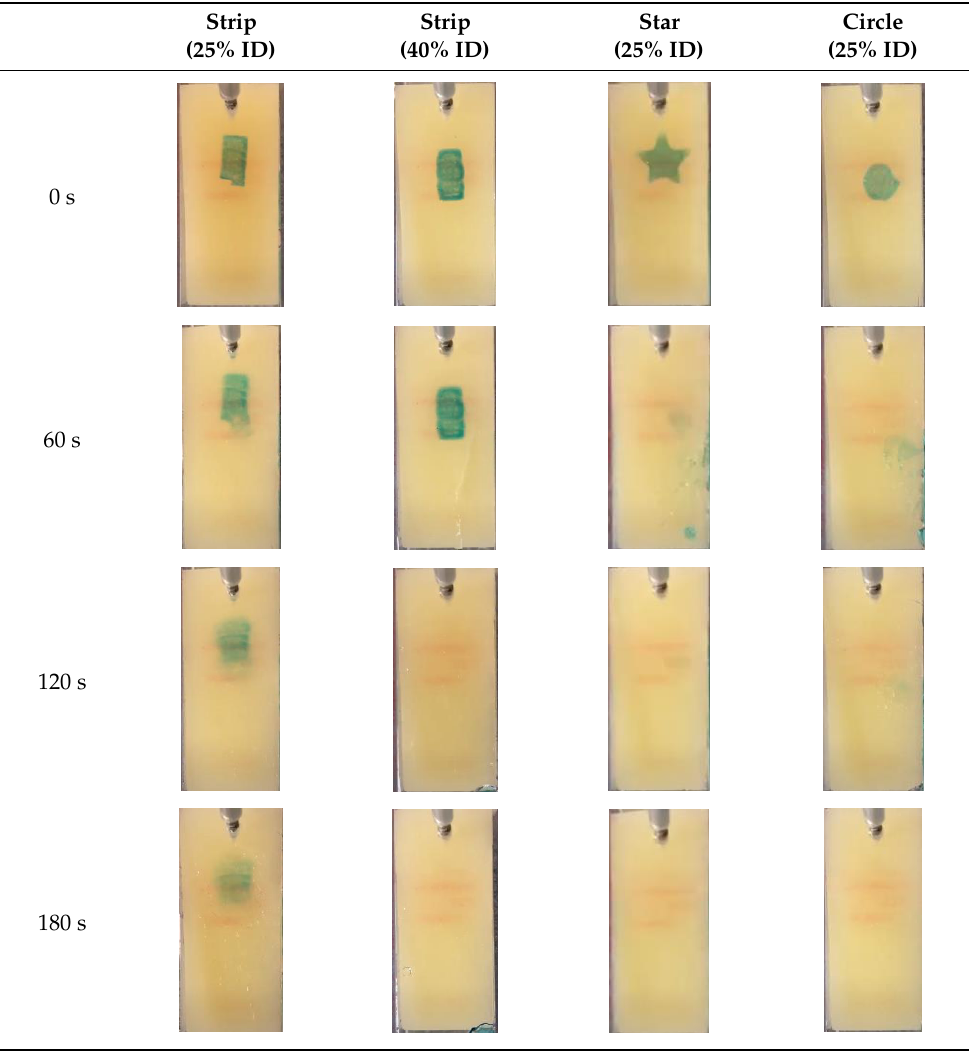
Table 4. Extracted frames from videos showing ODF samples during disintegration in OCM (ID—infill density).